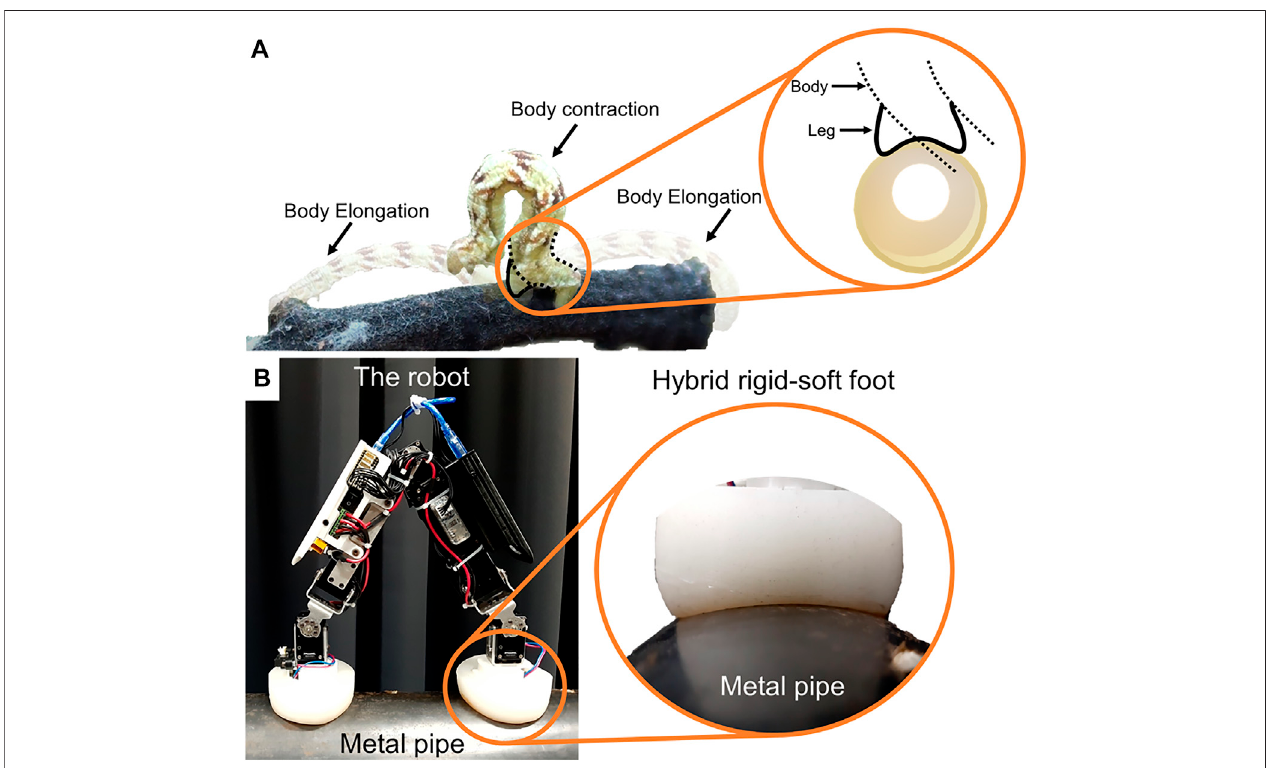
FIGURE 1 | (A) An inchworm crawls by attaching its legs to a tree branch. The inchworm body contracts and elongates during the crawling step (looping movement).Theschematicshowsitslegsappearingtoformaconcavecurvewhileadaptingtoaroundconvexsurface. (B)